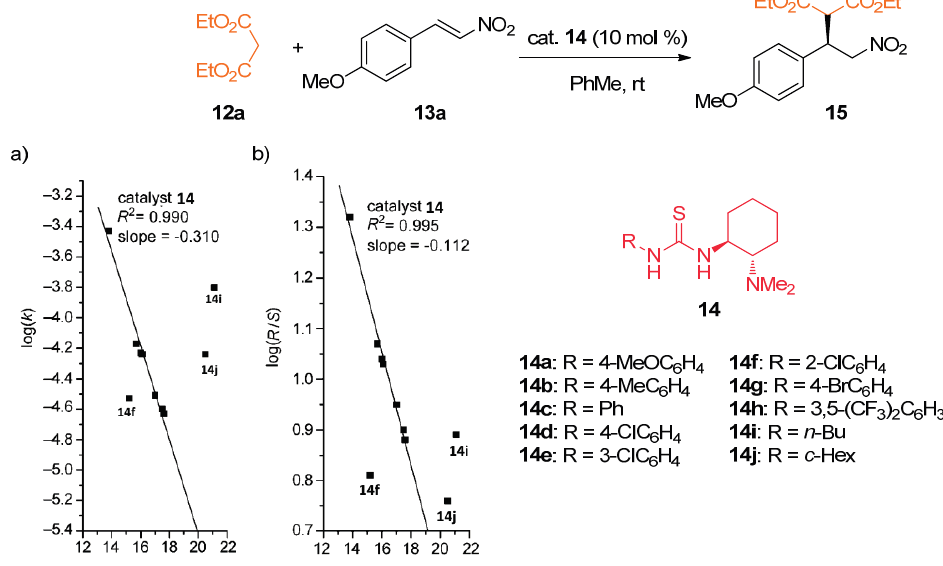
Figure 3. Correlations of p K a values with ( a ) reaction rates; ( b ) enantioselectivities for the Michael addition of diethyl malonate to nitrostyrene 13a . Adapted with permission from Ref. [27]. Copyright (2009) John Wiley and